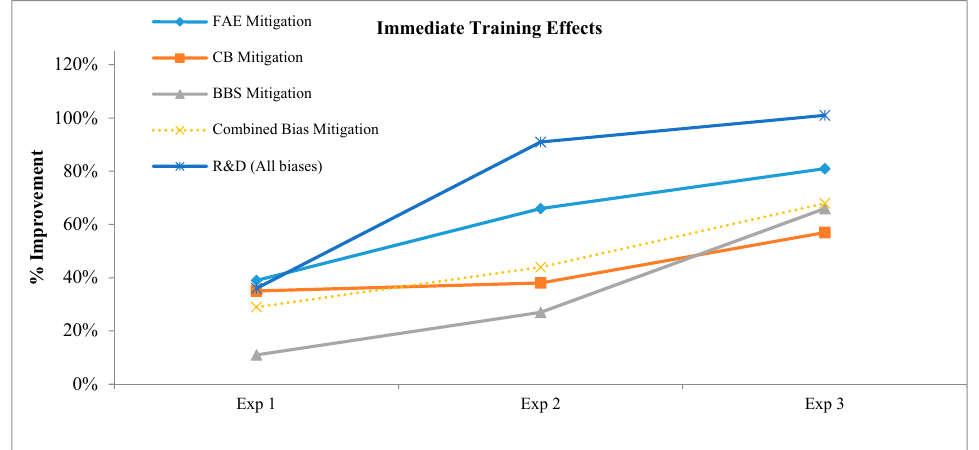
Figure 2. Immediate training effects by bias for best game per experiment for CYCLES Training Center. Experiment (Exp.) 1 n = 80; Exp. 2 n = 96; Exp. 3 n = 121. FAE mitigation—performance on a measure